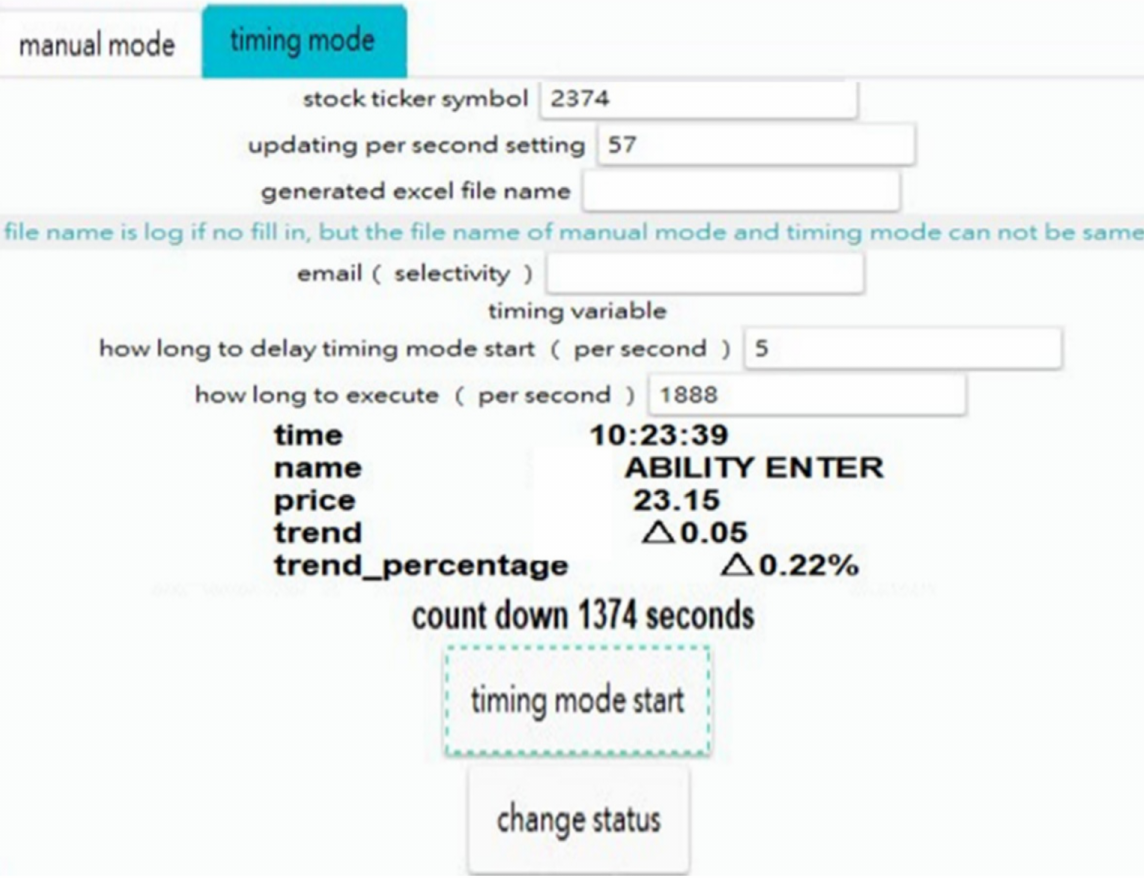
Figure 12. Timing mode count down 1374